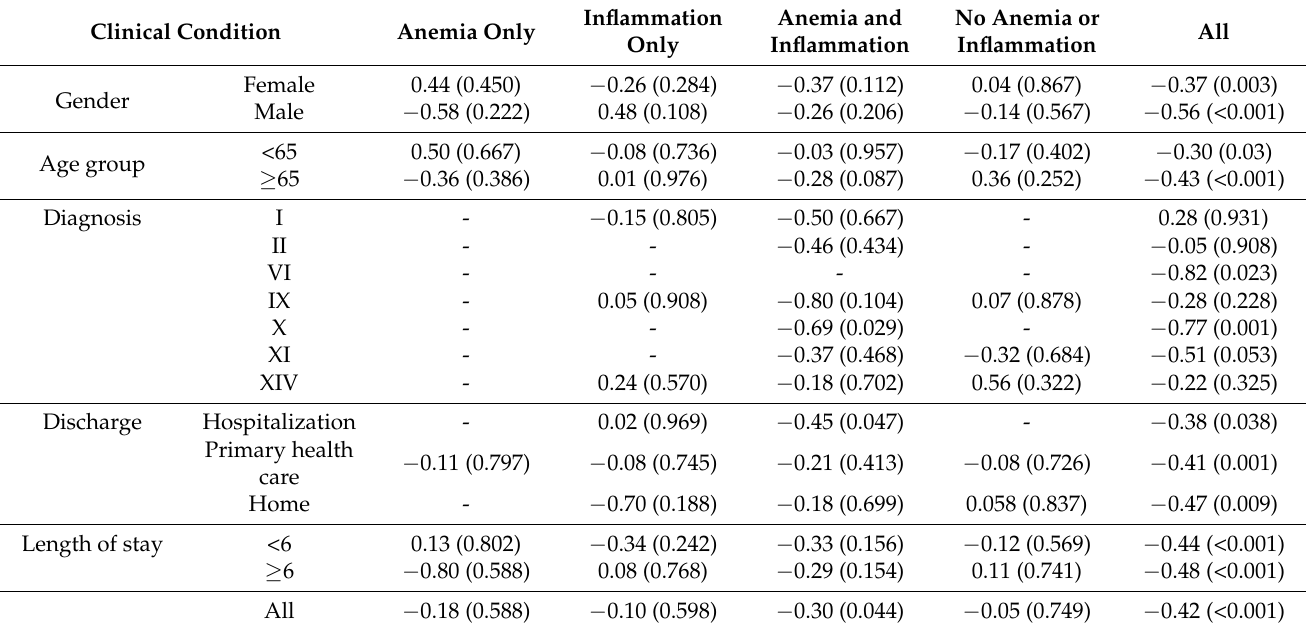
Table 3. Correlation between Hb and CRP in the studied subgroups, according to main characteristics and clinical conditions. Clinical